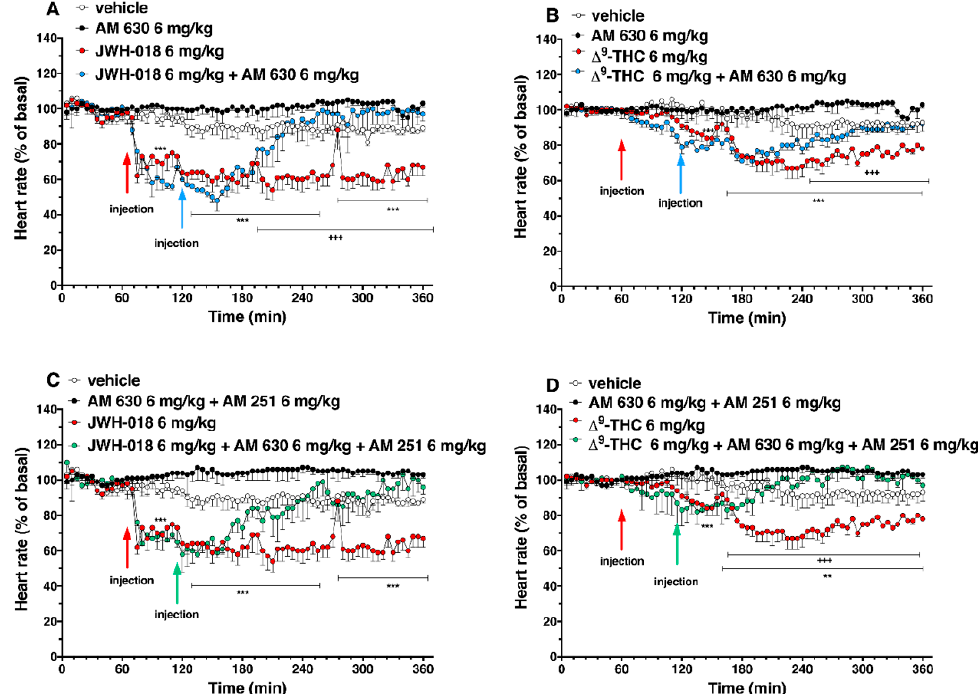
Figure 5. Interaction of JWH-018 (6 mg/kg i.p, panel ( A )) and ∆ 9 -THC (6 mg/kg i.p, panel ( B )) with the selective CB 2 receptor antagonist AM 630 (6 mg/kg, i.p.) on heart rate. Interaction of JWH-018 (6 mg/kg i.p, panel ( C )) and ∆ 9 -THC (6 mg/kg i.p, panel ( D )) with the administration of the mixture of selective CB 1 (AM 251; 6 mg/kg, i.p.) and CB 2 (AM 630; 6 mg/kg, i.p.) receptor antagonists on heart rate. Data are expressed as percentage of basal values in the form MEAN ± SEM of 8 different eval- uations for each group. Statistical analysis was performed by two-way ANOVA, followed by Bon- ferroni’s test for multiple comparisons. ** p < 0.01 *** p < 0.001 versus vehicle and +++ p < 0.001 versus AM 630 + agonists or AM 630 and AM 251 + agonists. < 0.0001), and time x treatment interaction (F 213, 2016 = 3.930, p < 0.0001). After the ∆ 9 -THC treatment, AM 630, totally reverted the effect only during the last two hours of experiment (Figure 5B; significant effect of treatment (F 3, 2016 = 355.4, p < 0.0001), time (F 71, 2016 = 8.743, p < 0.0001), and time x treatment interaction (F 213, 2016 = 3.231, p < 0.0001). Co-administration of AM 630 and AM 251 reverted the effects on heart rate of both JWH-018 (Figure 5C; significant effect of treatment (F 3, 2016 = 437.4, p < 0.0001), time (F 71, 2016 = 5.425, p < 0.0001), and time x treatment interaction (F 213, 2016 = 2.976, p < 0.0001) and ∆ 9 -THC (Figure 5D; sig- nificant effect of treatment (F 3, 2016 = 243.2, p < 0.0001), time (F 71, 2016 = 2.183, p < 0.0001), and time x treatment interaction (F 213, 2016 = 2.885, p < 0.0001) within the first hour from injection. 2.2. Electrocardiogram Parameters and Recording Electrocardiogram parameters have been evaluated after JWH-018 and ∆ 9 -THC ad- ministration at the highest dose (6 mg/kg, Table 1), relating it to the HR dose–response curve (Figure 2A,B).